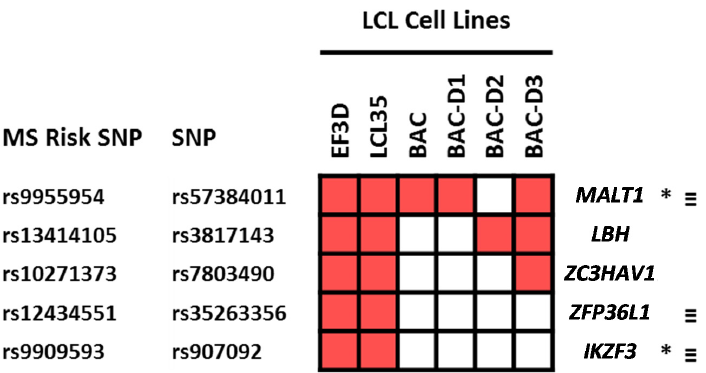
Figure 5. SNPs which are located within or close to miRNA target sites on MS risk genes and the replication of these interactions in the different LCL cell lines used in the PAR-CLIP study (red fill). * shows the genes which are involved in LCL latency III specific MS risk transcriptome. ≡ shows